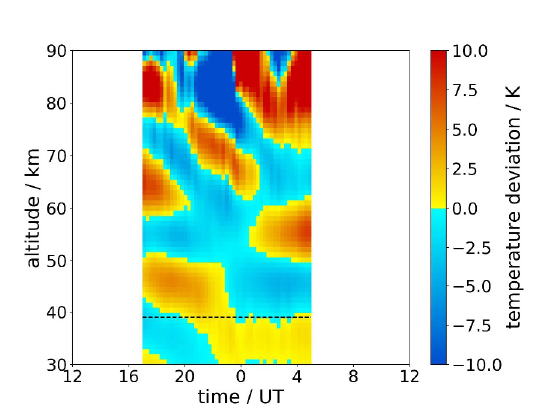
Fig. 5: Temperature variation after filtering with 15 km low-pass Butterworth filter. Waves with these large vertical wavelength are typically attributed to